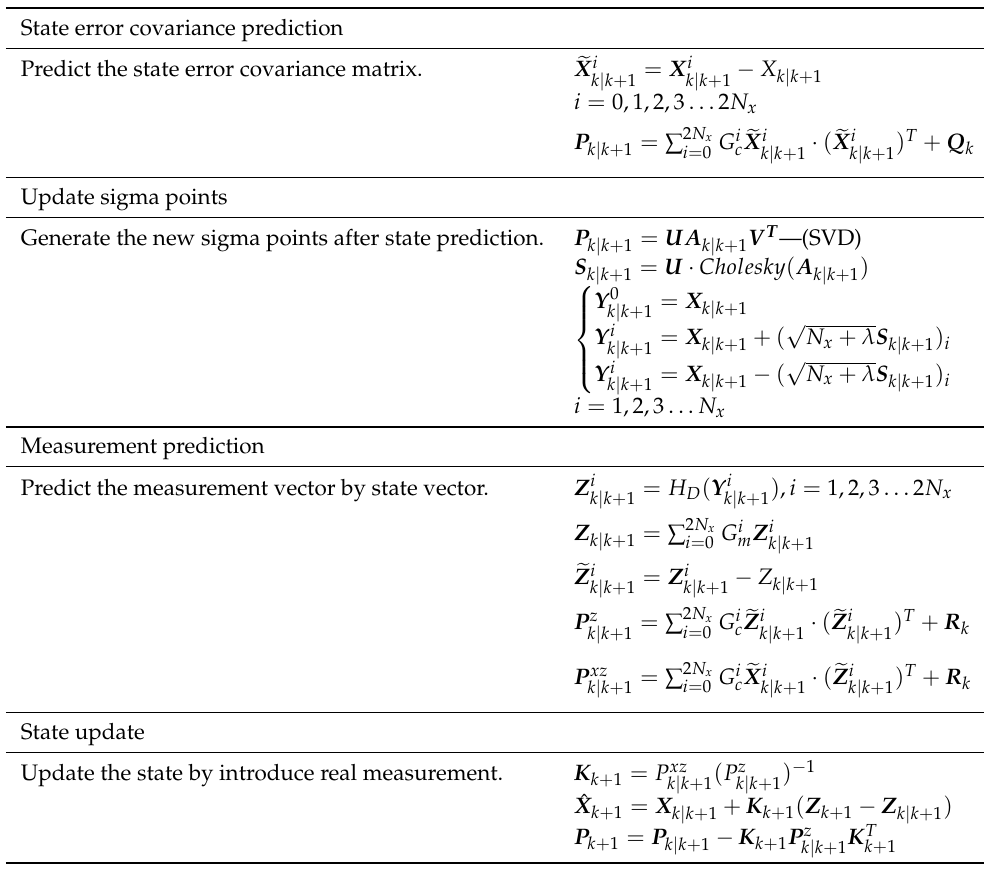
Table 2. Cont. State error covariance prediction Predict the state error covariance matrix.